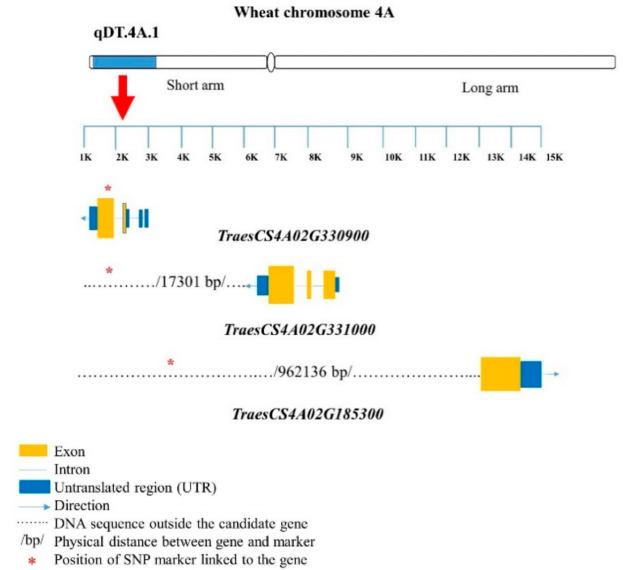
Figure 3. Structures of candidate genes in the qDT.4A.1 genomic region (GR). SNP markers are located in different positions of the genes. The genes were identified based on the 90K wheat microarray assessment of near-isogenic lines with contrasting root traits. SNP markers are located in different positions of the genes. Structural information of the genes and SNP markers were obtained from wheat genome database (https://urgi.versailles.inra.fr/jbrowseiwgsc/gmod_jbrowse/) (accessed on 2 March 2021). The measuring bar indicates the DNA length in kilo base pairs (kb).